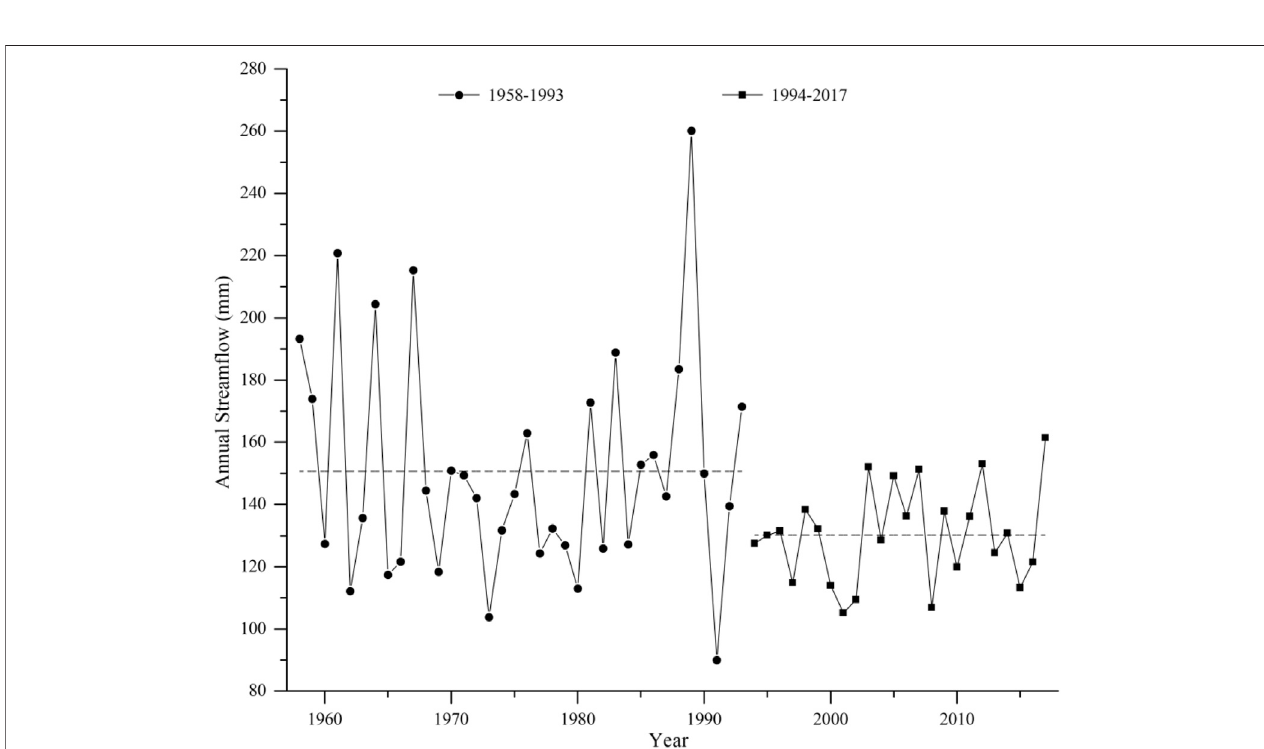
FIGURE 3 | Annual stream fl ow comparison of reference period and change period in the Huangshui River basin.